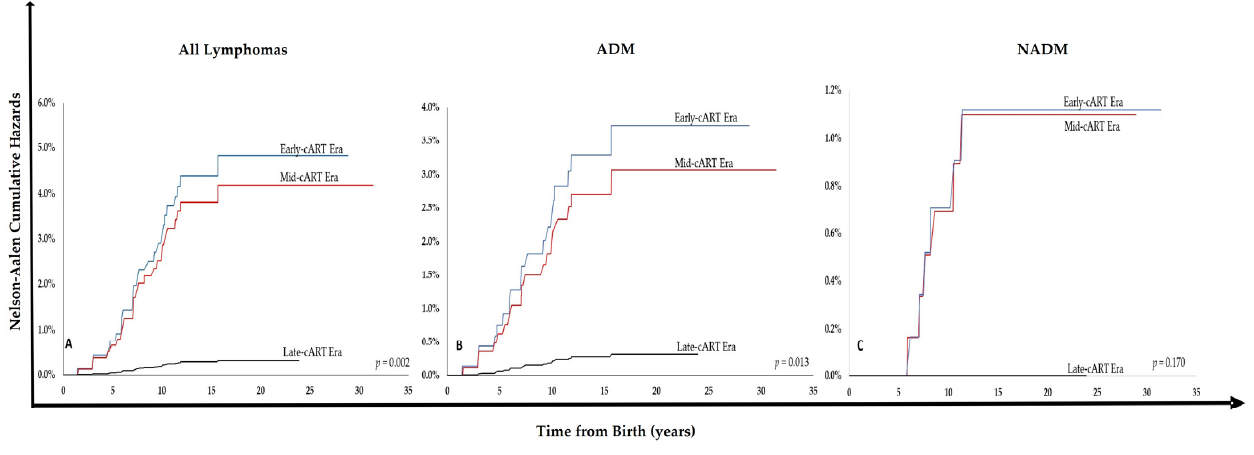
Figure 2. Nelson–Aalen Cumulative Hazards of Developing Lymphoma for HIV-vertically Infected Children per Era for all Lymphoma subtypes ( A ), ADM ( B ), and NADM ( C ). The HR for developing lymphoma between Early and Late-cART eras was 15.41 (CI = 2.01–117.83; p = 0.008) and between Mid and Late-cART eras was 13.38 (CI = 1.73–103.70; p = 0.013). For developing ADM, the HR between Early and Late-cART was 11.85 (CI = 1.52–92.60; p = 0.018) and between Mid and Late-cART was 9.76 (CI = 1.22–78.03; p = 0.032). Finally, the HR for developing NADM between Early and Late-cART was 1.33 (CI = 0.21–